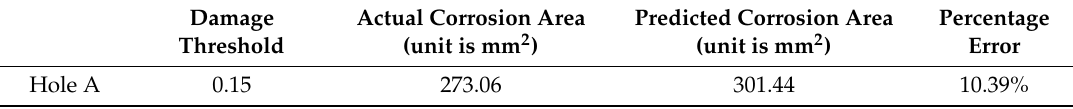
Table 3. Damage simulation and prediction